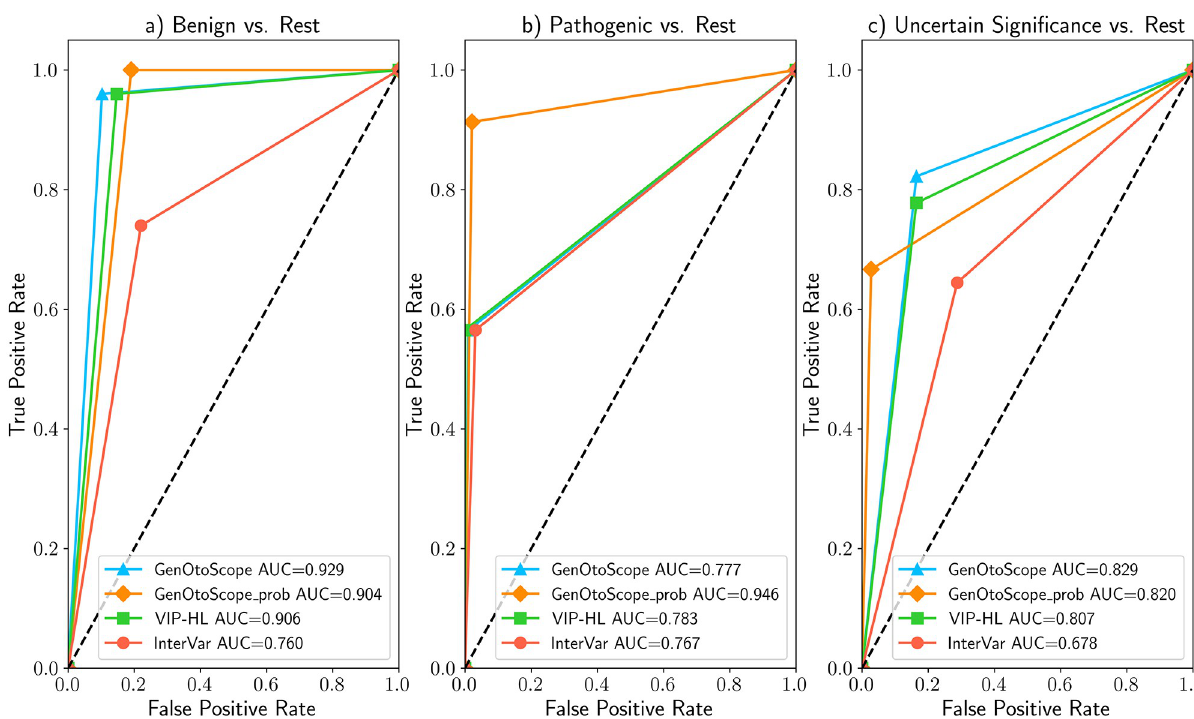
Fig 10. ROC curves and AUC scores of all classification tools for MHH data set. (A) Prediction of “Benign” broader class versus “Pathogenic” broader class and “VUS” class (B) Prediction of “Pathogenic” broader class versus “Benign” broader class and “VUS” class (C) Prediction of “VUS” class versus “Benign” broader class and “Pathogenic” broader